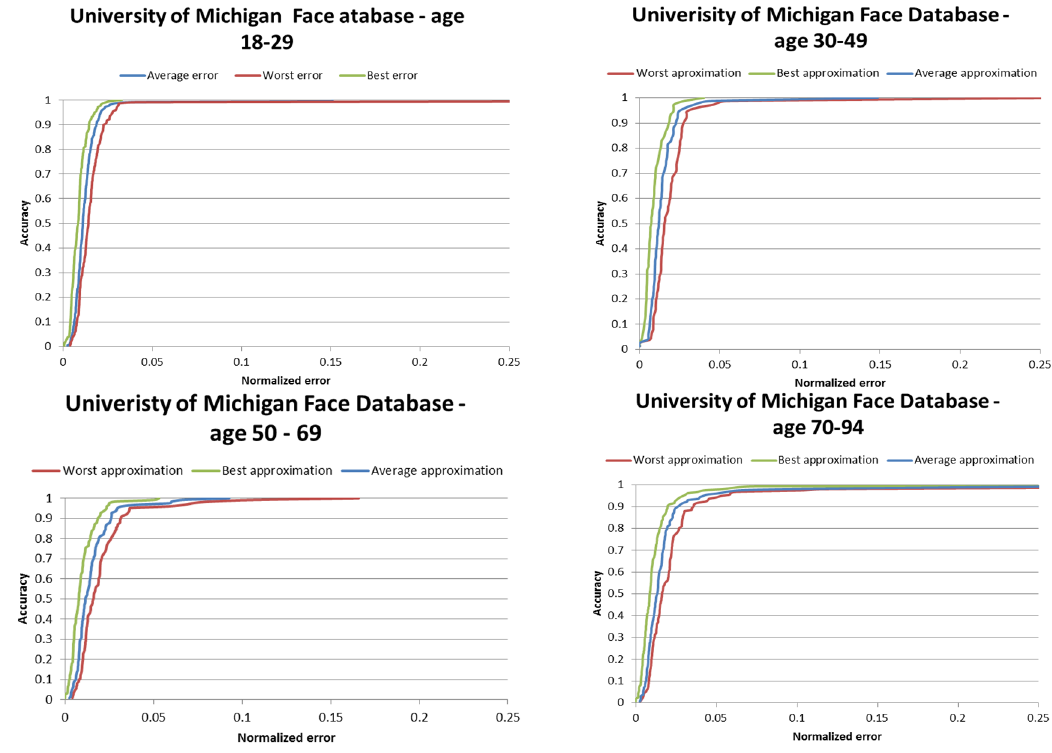
Figure 17. Performance of the iris center localization algorithm on the University of Michigan Face Database.